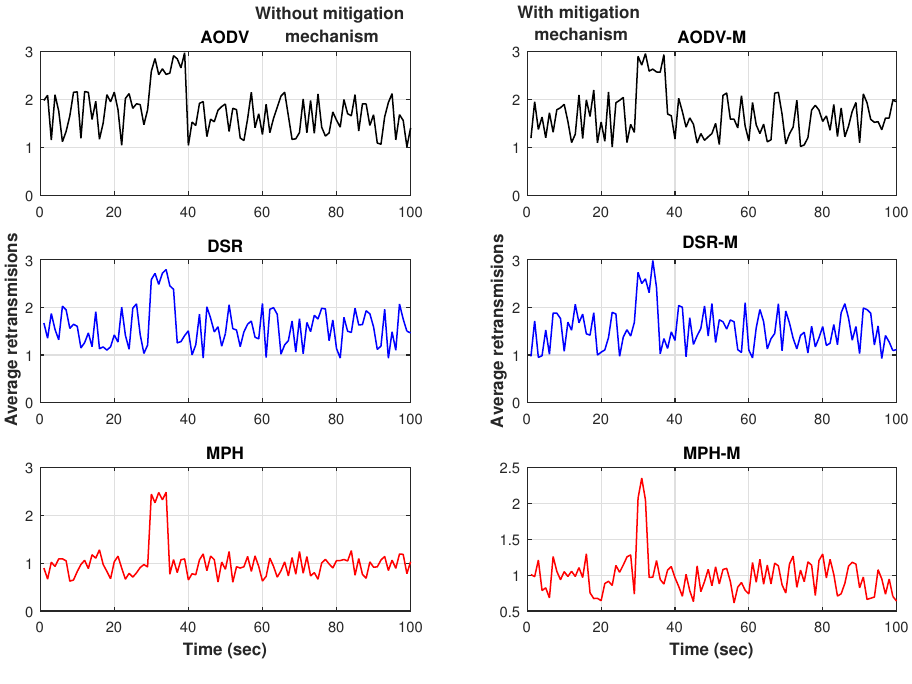
Figure 19. Resilience results for AODV, DSR and MPH and for AODV-M, DSR-M and